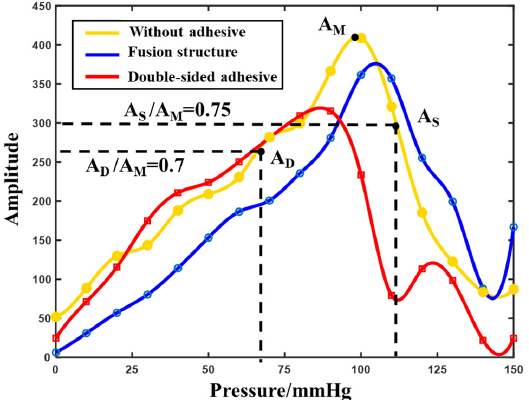
Figure 8. Pulse waveform with the biomimetic fusion structure adhesion at 150 − 0 mmHg pressure: ( a ) Global pulse waveform; ( b ) Pulse waveform at 40 mmHg pressure; ( c ) Pulse waveform at 80 mmHg pressure; ( b ) Pulse waveform at 120 mmHg pressure.